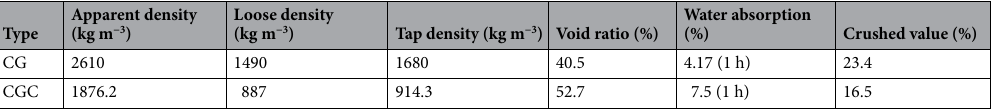
Table 3. Basic properties.